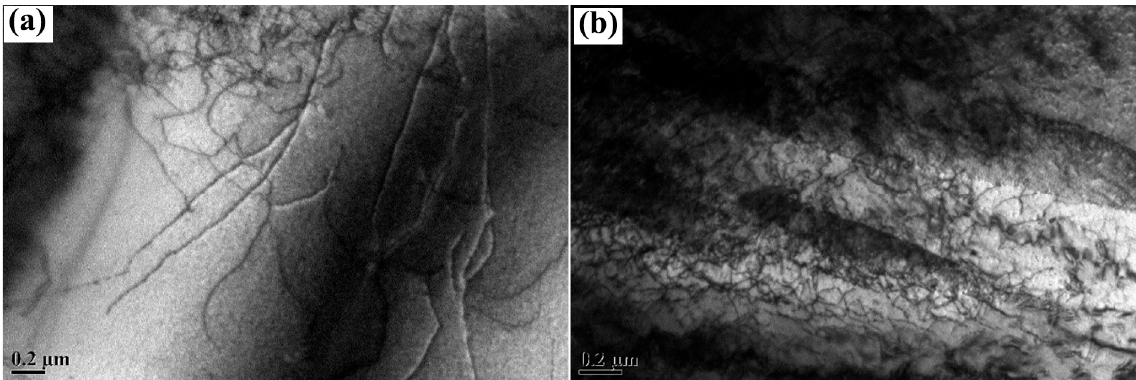
Figure 10. Dislocation con fi guration of test steel at di ff erent coiling temperatures: ( a ) 650 °C; ( b ) 600 °C.